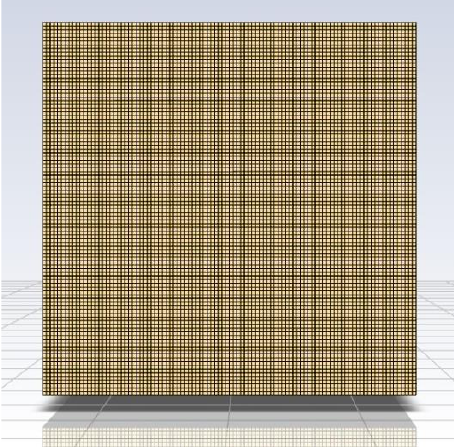
Figure 3. Schematic diagram of meshing.